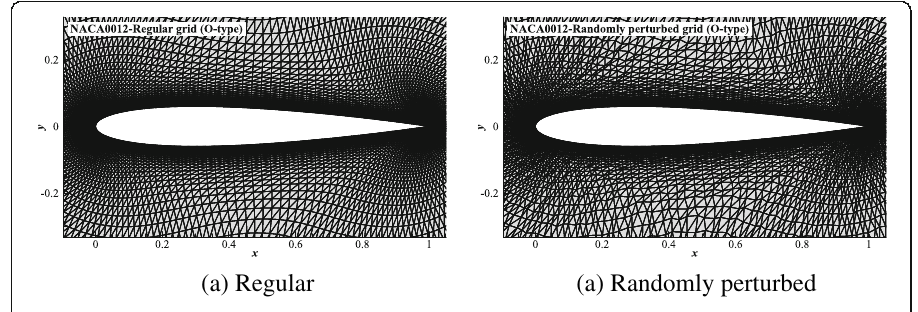
Fig. 23 ( a ) Regular and ( b ) randomly perturbed triangular grids with O -type over a NACA0012 airfoil